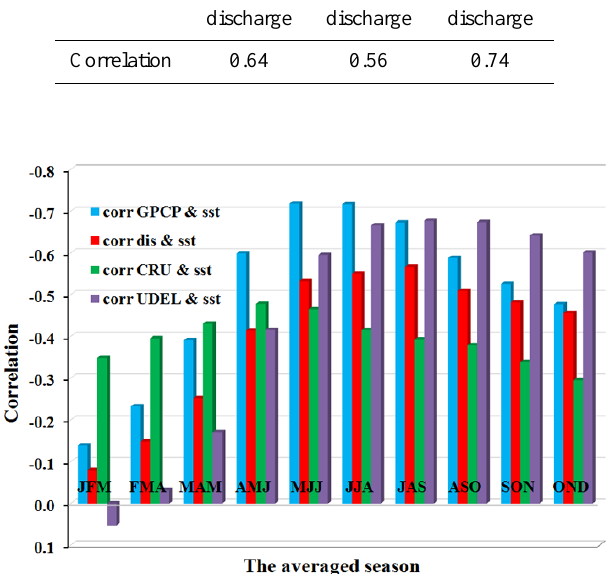
Fig. 9. Correlation between SST anomalies in Niño 3.4 region and the discharge anomalies at Eldiem station and the GPCP, UDEL and CRU rainfall in the upper catchment of the Blue Nile in the Ethiopian Highlands from 1982 to